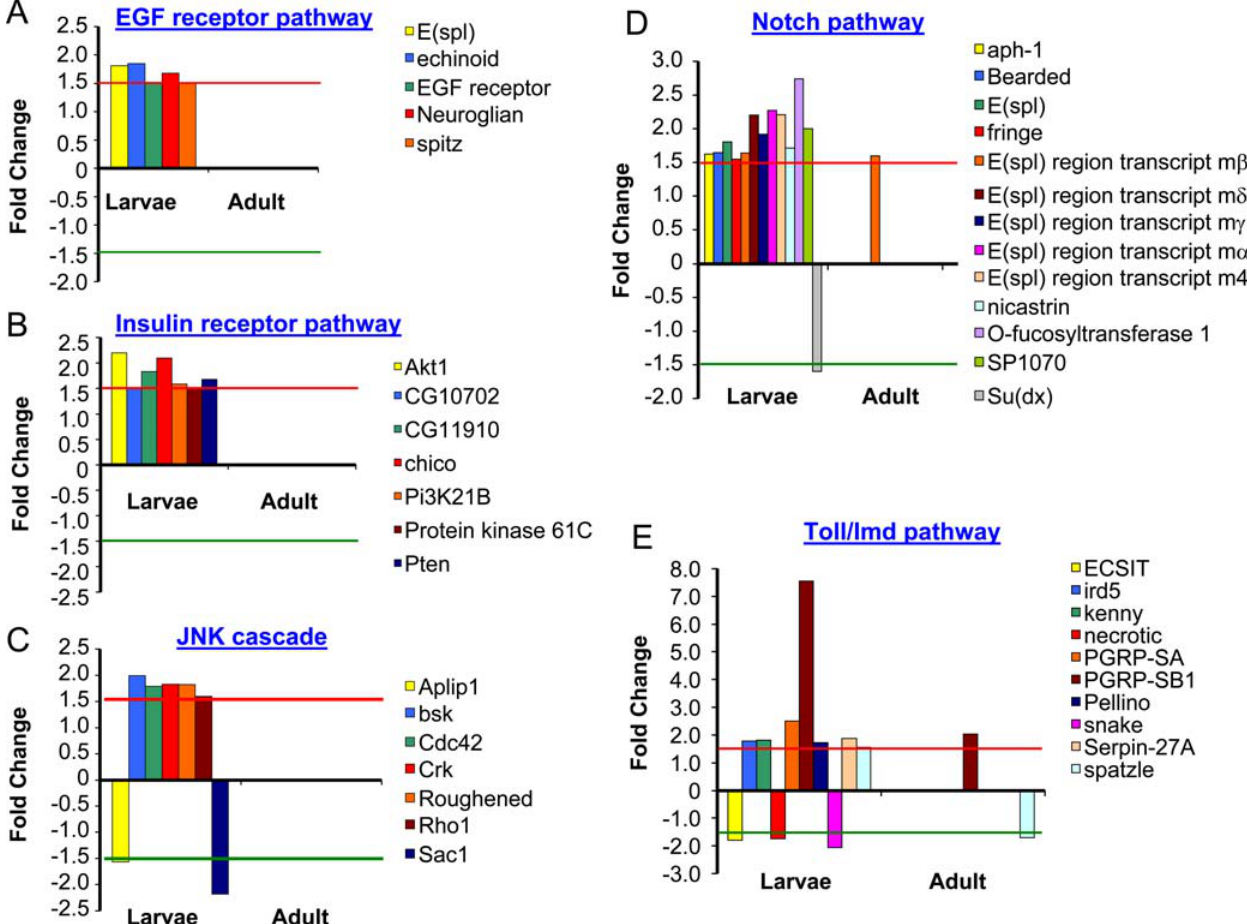
Figure 3. Summary of alterations in signal transduction pathways. The expression levels of genes encoding five signal transduction pathways were significantly altered in hypoxia-selected Drosophila melanogaster (p , 0.05). The majority of the changes was an up-regulation. Significantly altered genes encoding the components A) of EGF receptor pathway, B) of the Insulin receptor pathway, C) of the JNK cascade, D) of the Notch pathway, and E) of the Toll/Imd pathway.